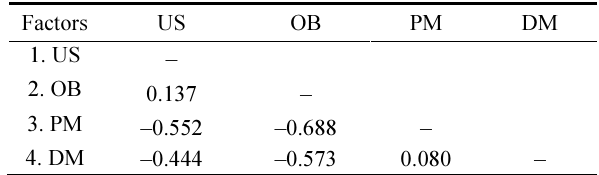
Table 12. Net influence matrix N of